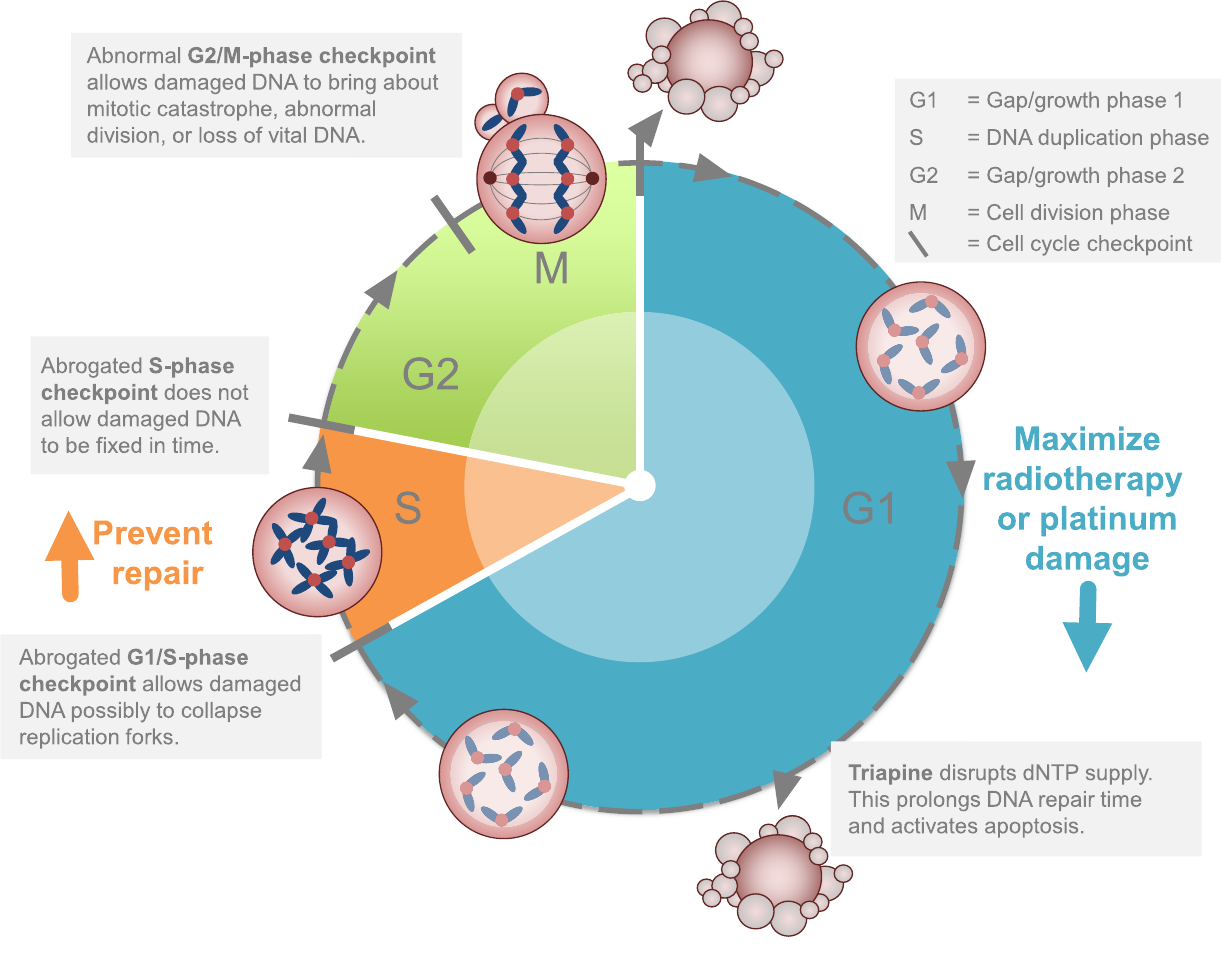
FigUre 2 | Strategy for ribonucleotide reductase (RNR) inhibitors in cervical or vaginal cancers. The clinical development strategy for RNR-targeted agents like triapine is to block or to stall DNA repair after a maximum amount of inflicted DNA damage occurs during the G1 or S phases of the cell cycle. This strategy is cytotoxic (1) by itself or (2) disrupts homologous recombination